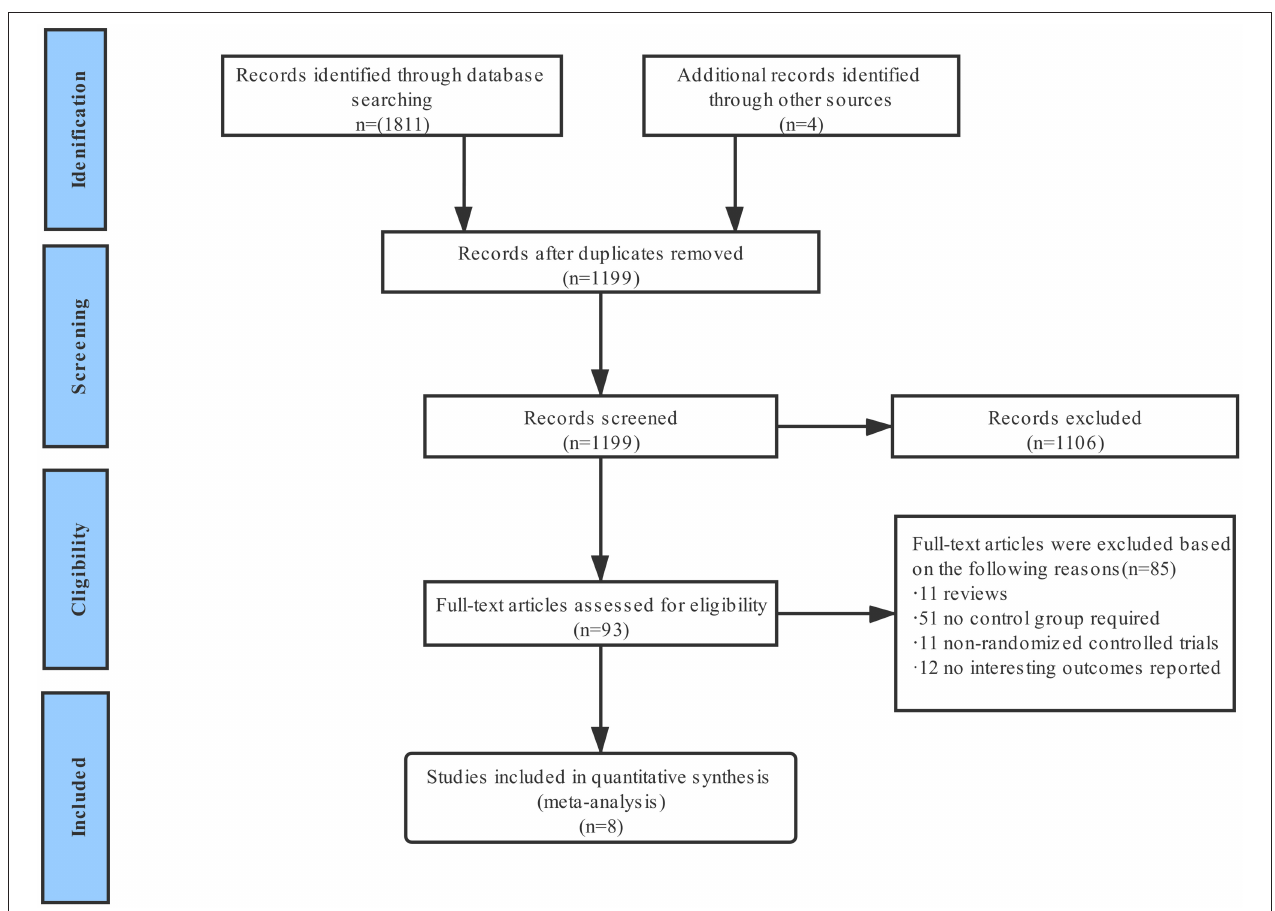
FIGURE 1 | Flow diagram of literature searching